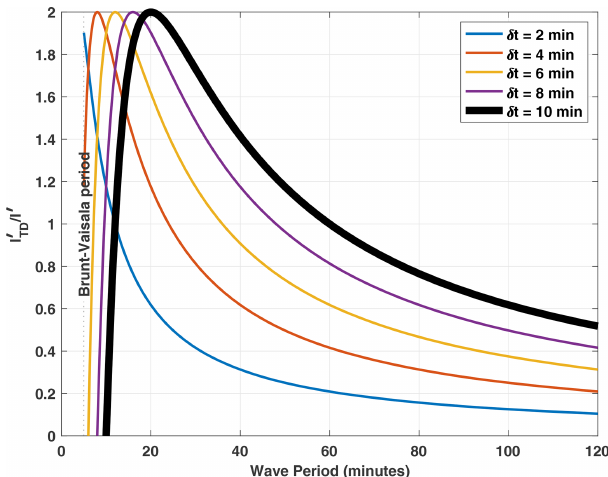
Figure B1. Effect of time difference image filter on gravity wave amplitudes of various periods and acquisition times ( δt ). The thick black line corresponds to the acquisition time of our imager during